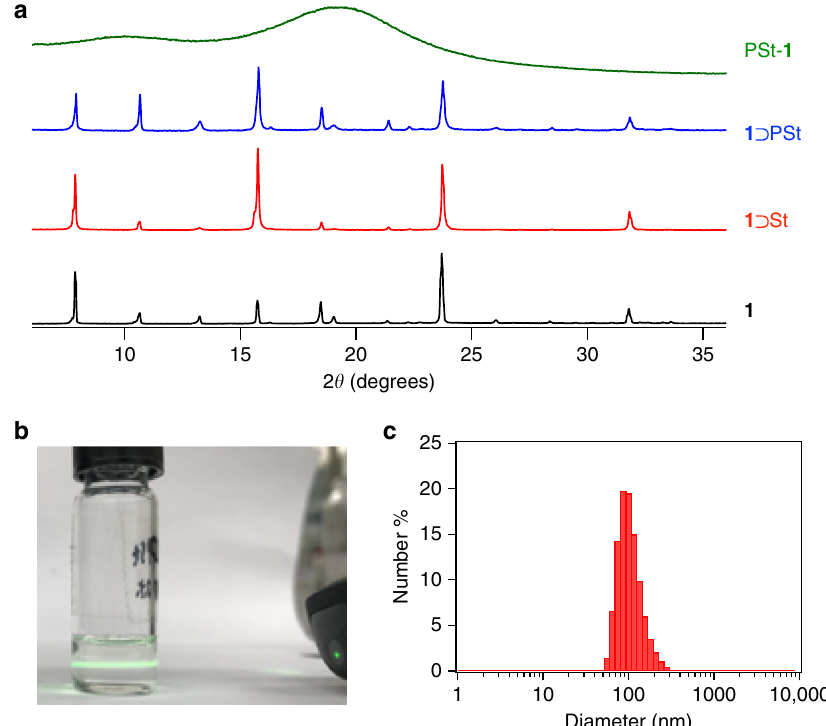
Fig. 3 Synthesis of 1 ⊃ PSt and PSt-1. a XRPD patterns of 1 , 1 ⊃ St, 1 ⊃ PSt, and isolated PSt- 1 . b The Tyndall effect observed by passing a laser beam through the chloroform dispersion of PSt- 1 . c Size distribution of PSt- 1 measured by DLS in chloroform at 25